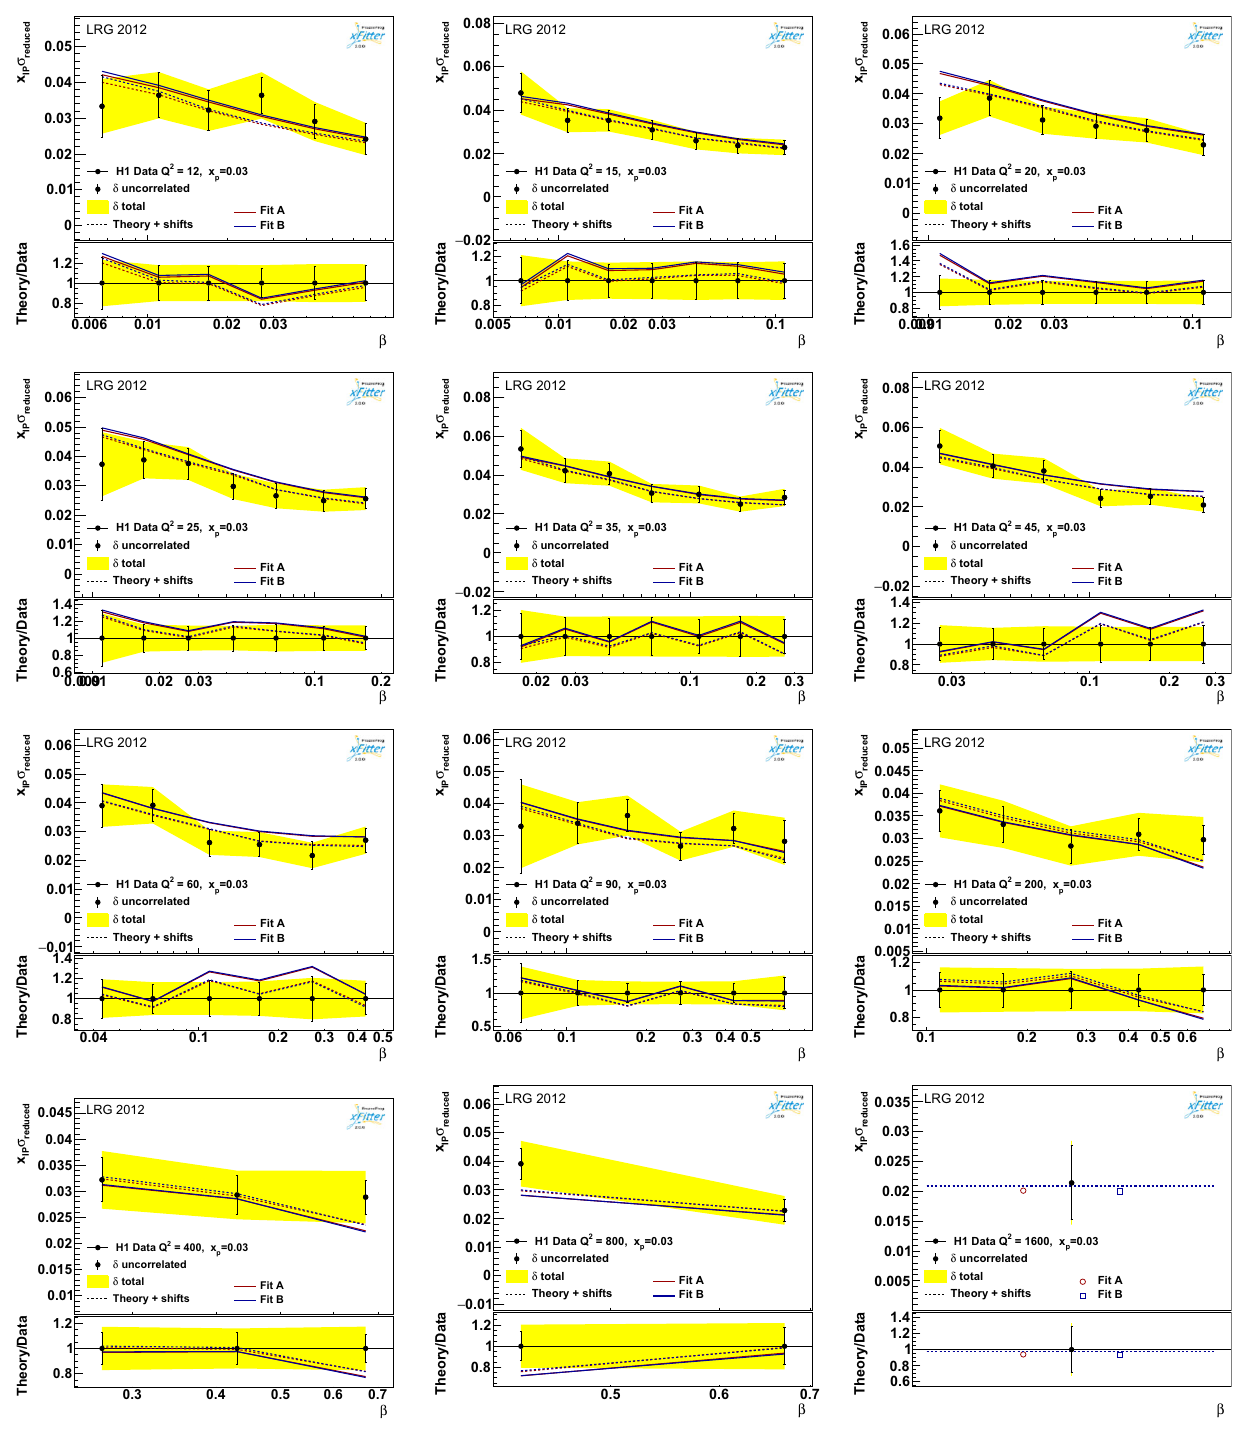
( 3 ) β for x = 0 . 03 in Fig. 11 The results of our NLO pQCD fit based on Fit B for the reduced diffractive cross section x IP σ D IP r as a function of comparison with H1-LRG-2012 data [44]. See the caption of Fig. 8 for further details function of β for x IP = 0 . 003 and Q 2 = 11 . 5 GeV 2 in com- total uncorrelated and correlated uncertainties, respectively. √ s = 225 GeV (left) parison with H1-LRG-2011 data at As can be seen, in the kinematics considered, the theory is and 319 GeV (right). The error bars on the data points and the again in good agreement with the yellow bands represent the uncorrelated uncertainties and the